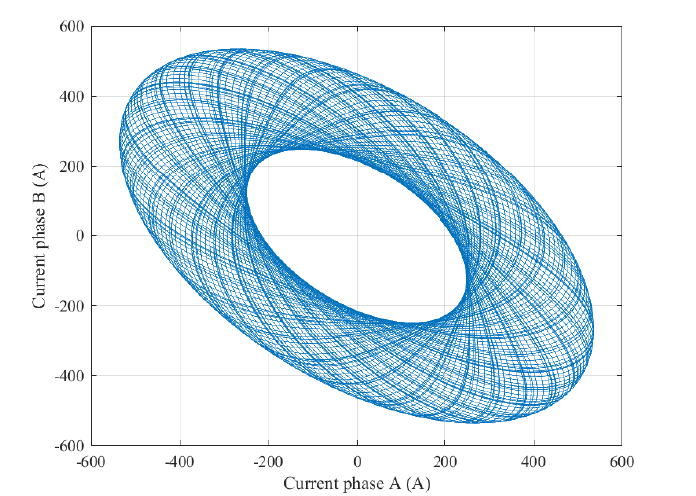
Figure 6. Phase portrait between DG1 currents phase A and B. Neimark–Sacker supercritical bifurca- tion forming a torus